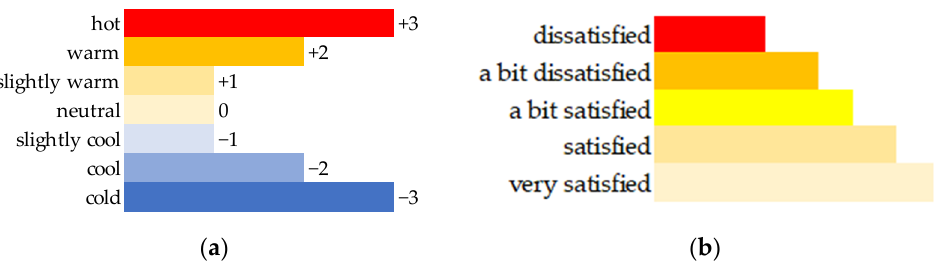
Figure 5. Personal thermal comfort metrics. ( a ) The 7-point thermal sensation; ( b ) 5-point thermal satisfaction.